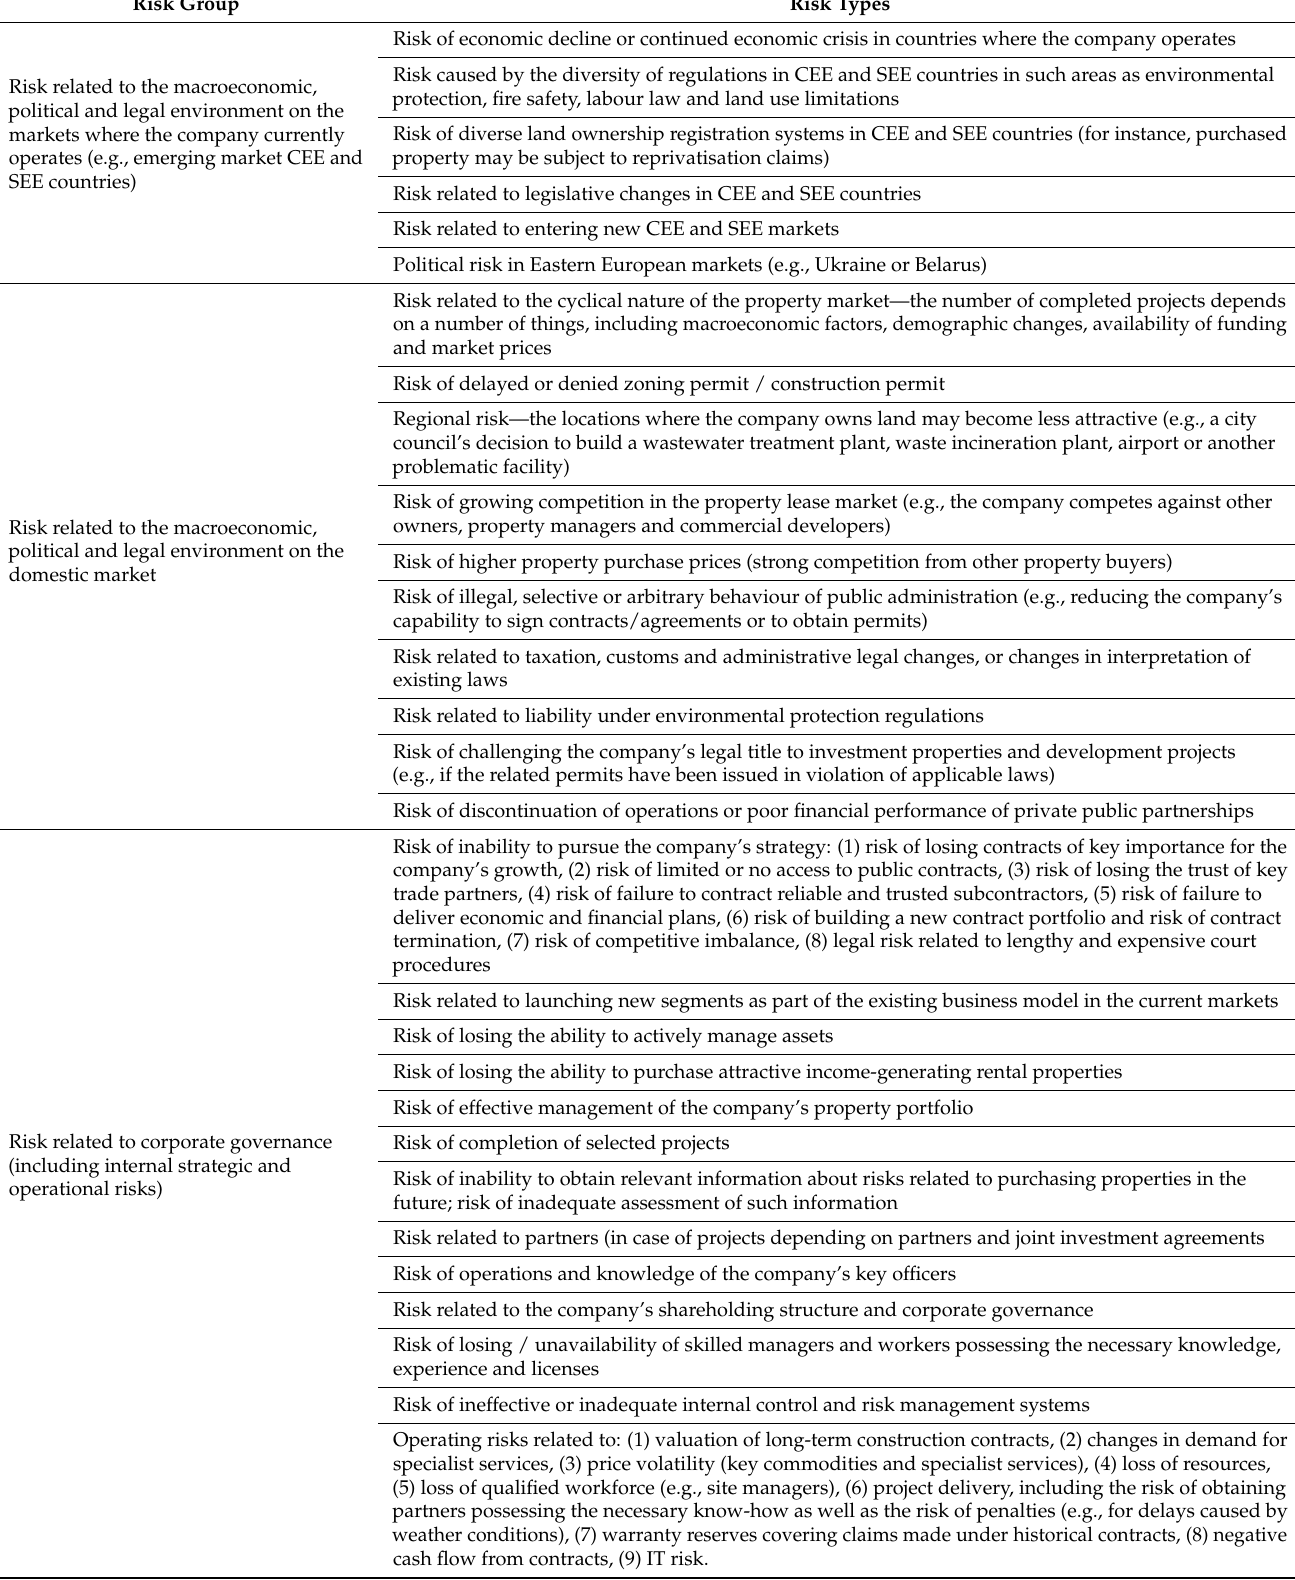
Table 5. Model classification of risks to be disclosed in CSR or integrated reports by companies operating in the construction and property development